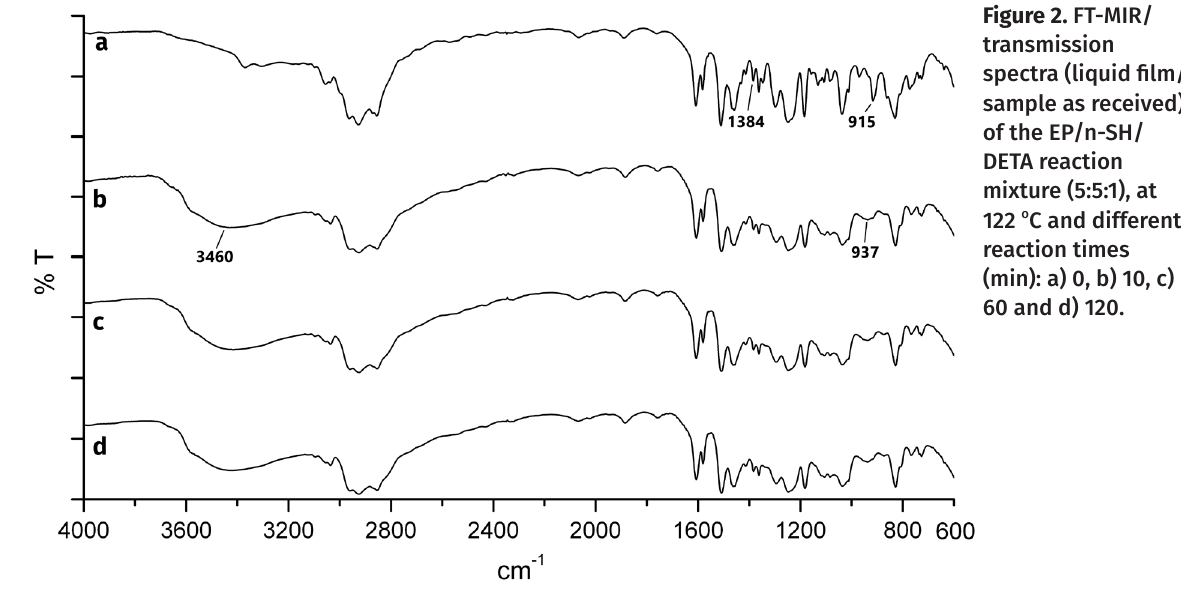
Figure 2. FT-MIR/ transmission spectra (liquid